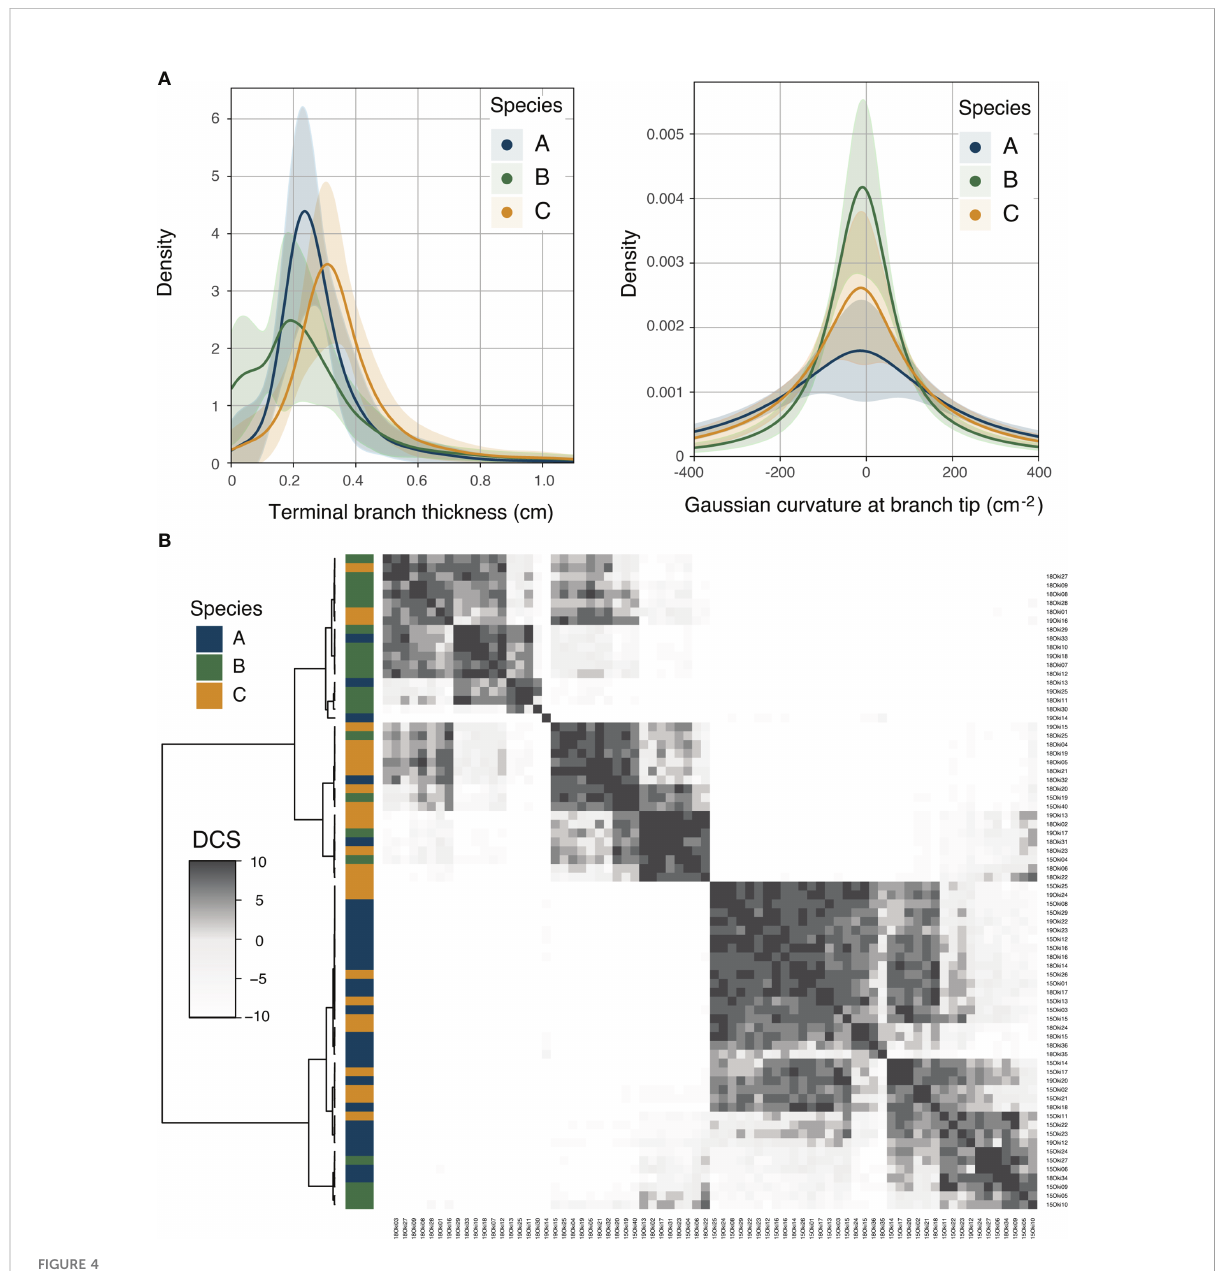
FIGURE 4 Kernel density distribution analyses. (A) Probability density functions of the terminal branch thickness ( dc ) and the Gaussian curvature at branch tip ( K_tip ) for each of the species. (B) Heatmap depicting recoded and summarized p -values obtained from two-sample Mann-Whitney U tests for minimum curvature ( k2 ). Samples were re-organized using hierarchical clustering according to similarity in pairwise comparisons, calculated as the distribution comparison score (DCS) or the cumulative value of similarity according to the p -value signi fi cance cut-off ( a =